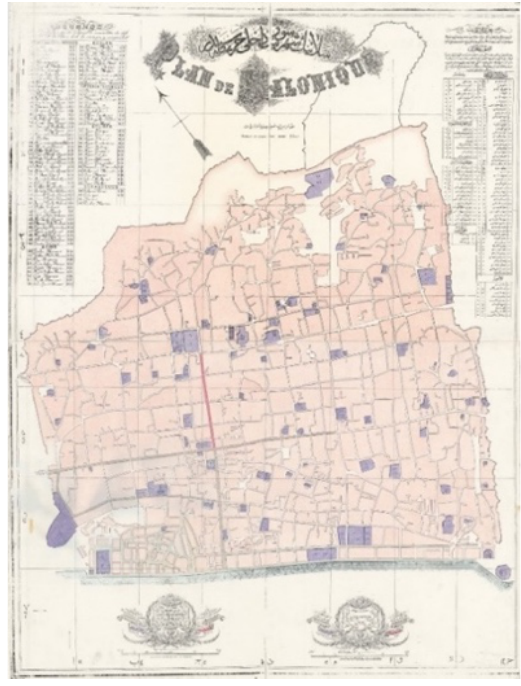
Figure – 2 Charles E. Goad Map 1905, Izmir. Retrieved